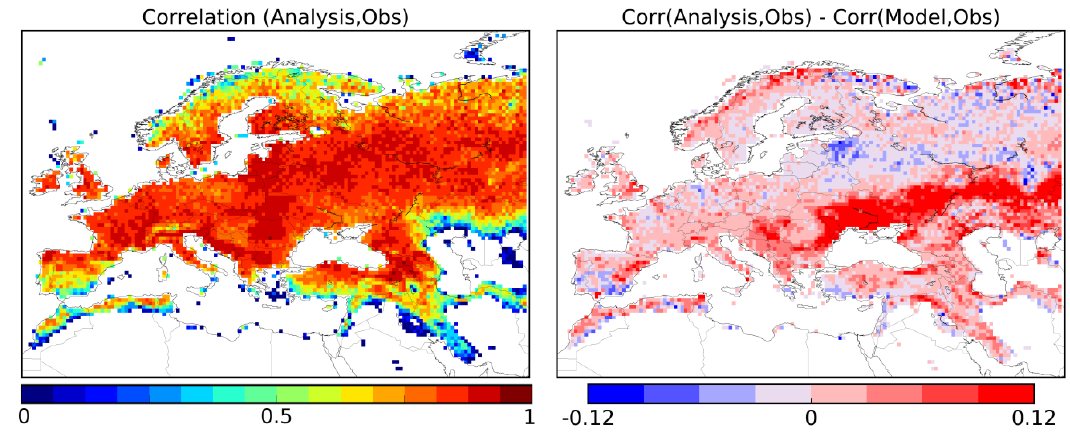
Figure 8. Correlation maps between the SIF observations and the GPP analysis for the whole 2007–2015 period (left column) and the difference map (right column, where red means an improvement after